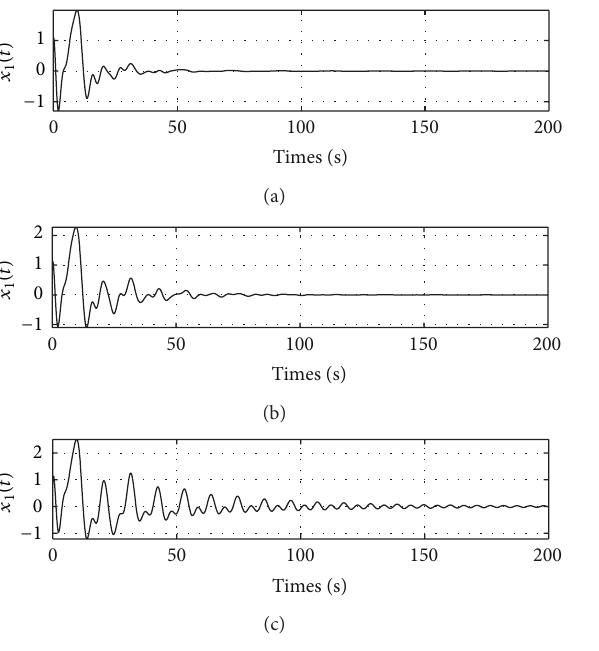
Figure 7: Effect of prediction horizon on control inputs: (a) Case 1 ( 𝑇 = 10 ), (b) Case 2 ( 𝑇 = 20 ), and (c) Case 3 ( 𝑇 = 30